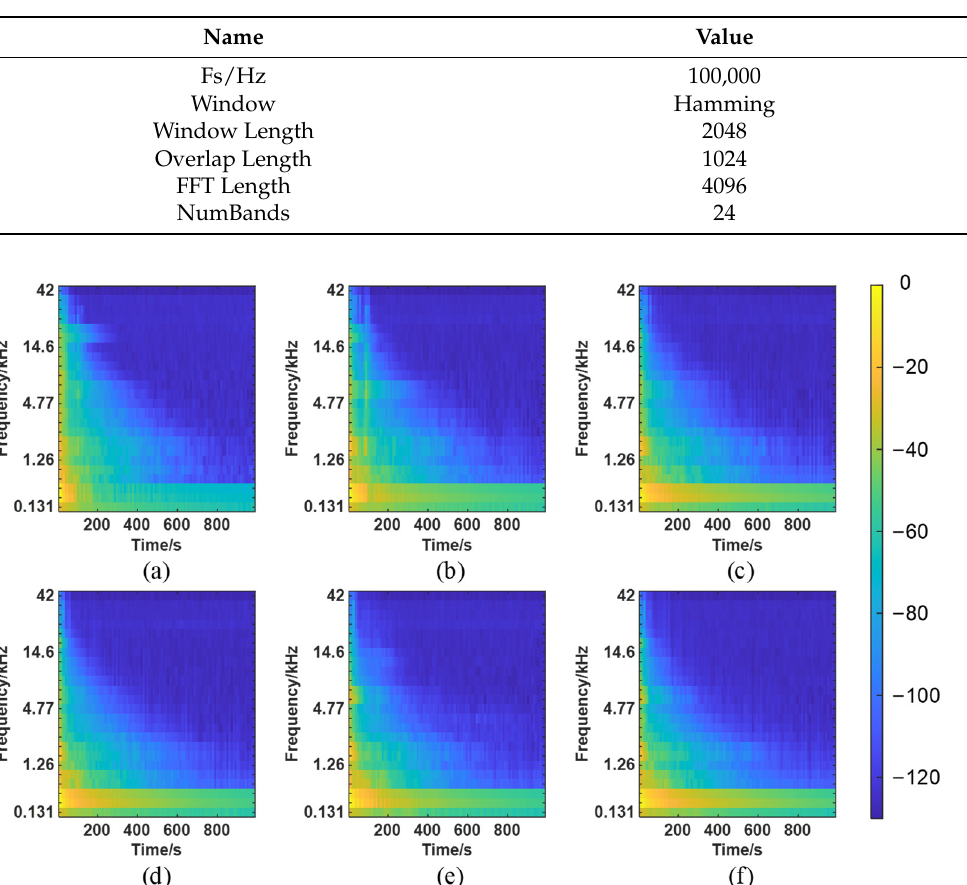
Table 3. Mel spectrogram Parameters.